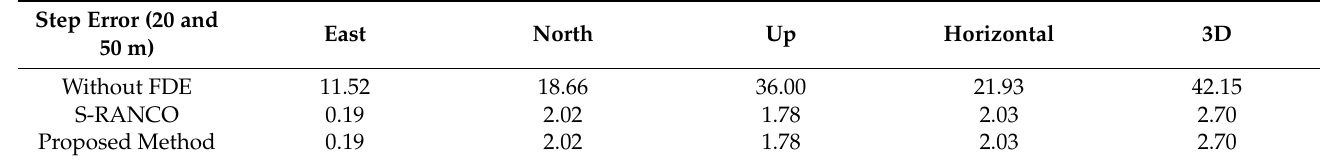
Table 10. The RMSE (m) of positioning results for Scenario 3.